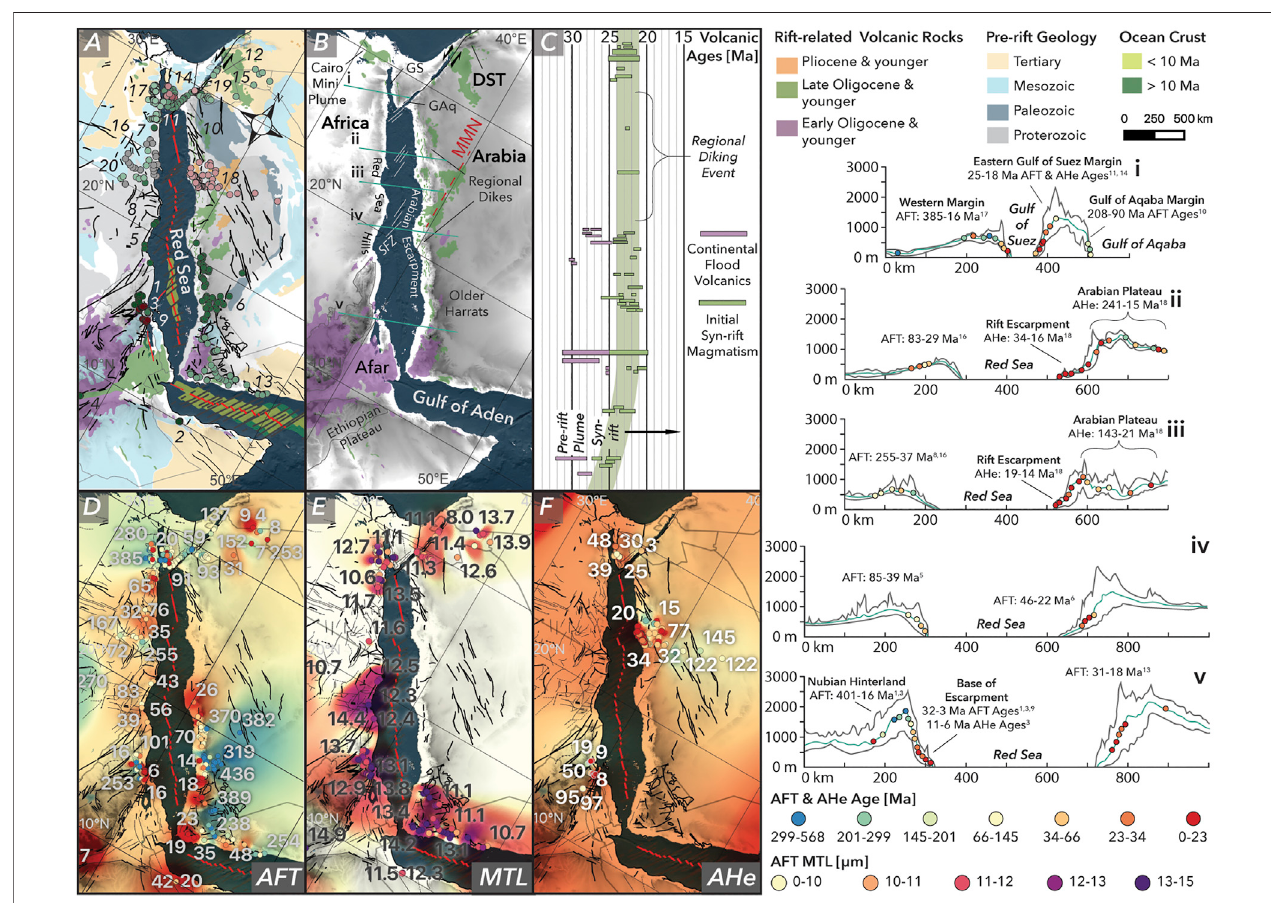
FIGURE 1 | Synthesis of the surface geology, plume and syn-rift volcanism, topography and low-temperature thermochronology of the Red Sea and adjacent hinterlands. (A) Simpli fi ed geological map (after Bosworth, 2015; Thiéblemont et al., 2016; Bosworth and Stockli, 2016) showing the locations of published AFT (green circles: 1,2 Abbate et al., 2002, 2001; 3 Balestrieri et al., 2005; 4 Abebe et al., 2010; 5 Balestrieri et al., 2009; 6 Bohannon et al., 1989; 7 Bojar et al., 2002; 8 Feinstein et al., 2013; 9 Ghebreab et al., 2002; 10 Kohn and Eyal, 1981; 11 Kohn et al., 1997; 12 Kohn et al., 2019; 13 Menzies et al., 1992, 1997; 14 Morag et al., 2019; 15 Naylor et al., 2013; 16,17 Omar et al., 1987, 1989) and AHe data (red circles: 3 Balestrieri et al., 2005; 12 Kohn et al., 2019; 14 Morag et al., 2019; 18 Szymanski et al., 2016; 19 Vermeesch et al., 2009). Note, detailed AFT data from Omar and Steckler (1995) was not published (location 20). (B) Digital elevation model of the Red Sea region illustrating the distribution of pre-rift plume-related continental fl ood volcanics and initial syn-rift volcanism, with the locations of swath pro fi les ( righthand ) shown with representative AFT and AHe ages projected onto them (correspondingreferencenumbers refer tostudy locations). Pre-existing shear zones, such as theShagaraFracture Zone (SFZ) shown in white, after Crane and Bonatti (1987). The corresponding radiometric determined emplacement ages are illustrated in a chronogram (C) after Bosworth and Stockli(2016). (D – F) Inversedistanceweightedinterpolations(distancecoef fi cientPof5)ofAFTages,AFTmeantracklengths(MTL)andAHemediansinglegrainages. While thermochronology data are sporadically distributed along the Red Sea margins, AFT and AHe ages proximal to the coast appear to generally increase and corresponding MTL decrease northwards. In all panels, dark solid lines are major faults, light solid lines are minor faults, hashed lines are inferred faults and red lines are spreading ridges (from Thiéblemont et al., 2016). DST, Dead Sea Transform; GS, Gulf of Suez; GAq, Gulf of Aqaba; MMN, Makkah-Madinah-Nafud volcanic line.